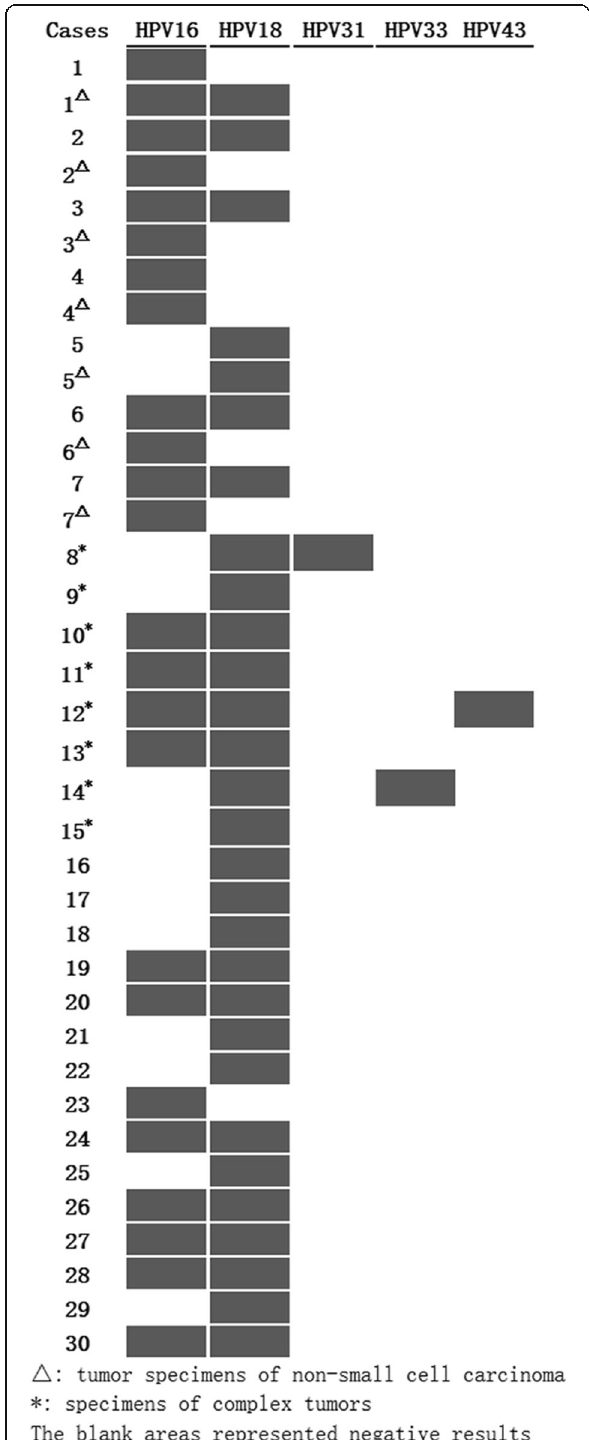
Fig. 4 HPV typing using polymerase chain reaction-reverse dot blot